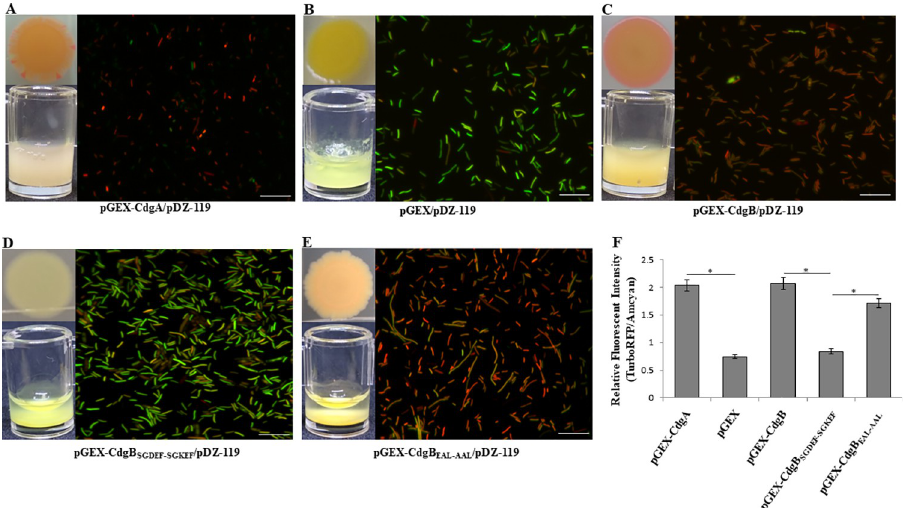
Fig 8. CdgB promotes c-di-GMP accumulation in a heterologous host. Representative images of macroscopic and microscopic observations of c-di-GMP levels judged by green and red coloring of colony spots and liquid concentrates as well as green and red fluorescence of individual cells from strains harboring the genetic biosensor in pDZ-119 and (A) pGEX-CdgA (DGC positive control), (B) pGEX-4T1 (negative control), (C) pGEX-CdgB, (D) pGEX-CdgB SGDEF-SGKEF , or (E) pGEX-CdgB EAL-AAL . (F) The relative fluorescence intensity represents the ratio between the TurboRFP and AmCyan fluorescence intensities and is directly proportional to c-di-GMP levels, as analyzed using ImageJ software. The RFI values represent the standard deviations of three biological replicates, and significant differences are indicated at � ( P < 0.05) according to Student´s t-test by SigmaPlot. The white bar corresponds to 10 μ